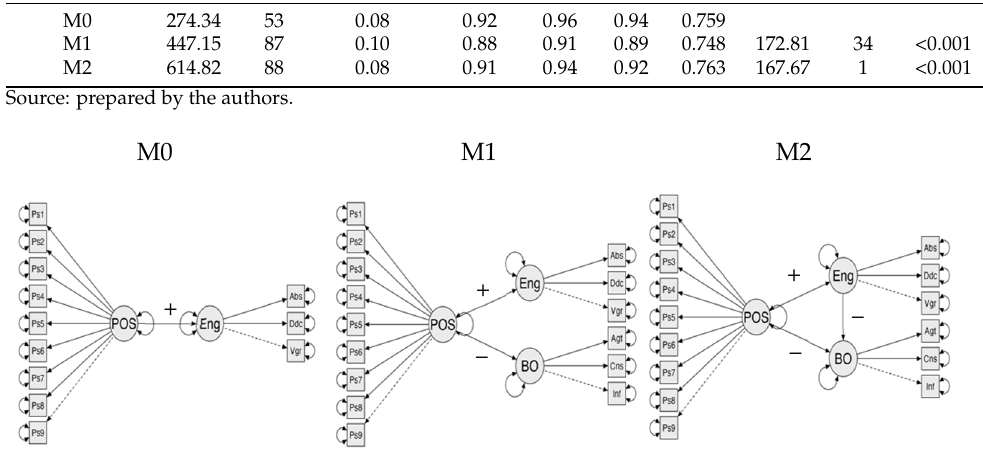
Figure 1. Specifications of hypothesized models of confirmatory structural equations. If there are multiple panels, they should be listed as: ( M0 ) healthy organizational practices (HOP) impact en- gagement; ( M1 ) HOP impact engagement and burnout separately; ( M2 ) HOP impact engagement and burnout, and engagement mediates between HOP and burnout. Source: prepared by the au- thors. Table 2. Fit index for structural equation models.